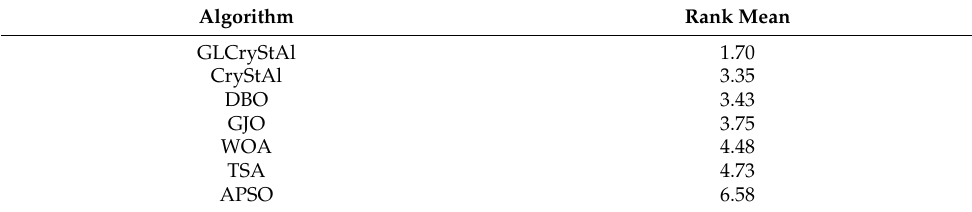
Table 6. Friedman analysis results.